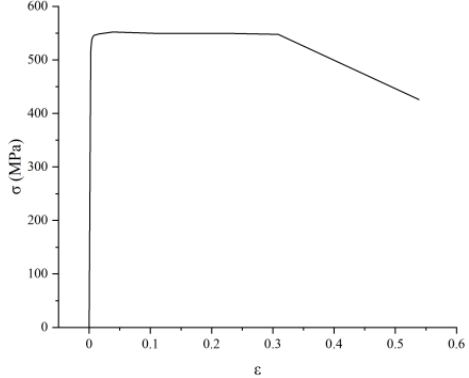
Figure 3. True stress–strain curve of ML15.